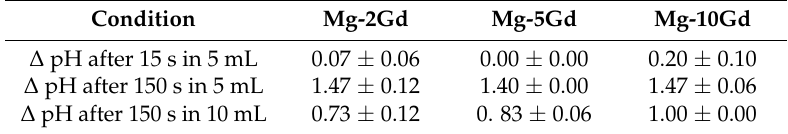
Table 3. Δ pH of HAc solution after etching the Mg- x Gd alloys in 5 and 10 mL solution. Table 3. ∆ pH of HAc solution after etching the Mg- x Gd alloys in 5 and 10 mL solution.